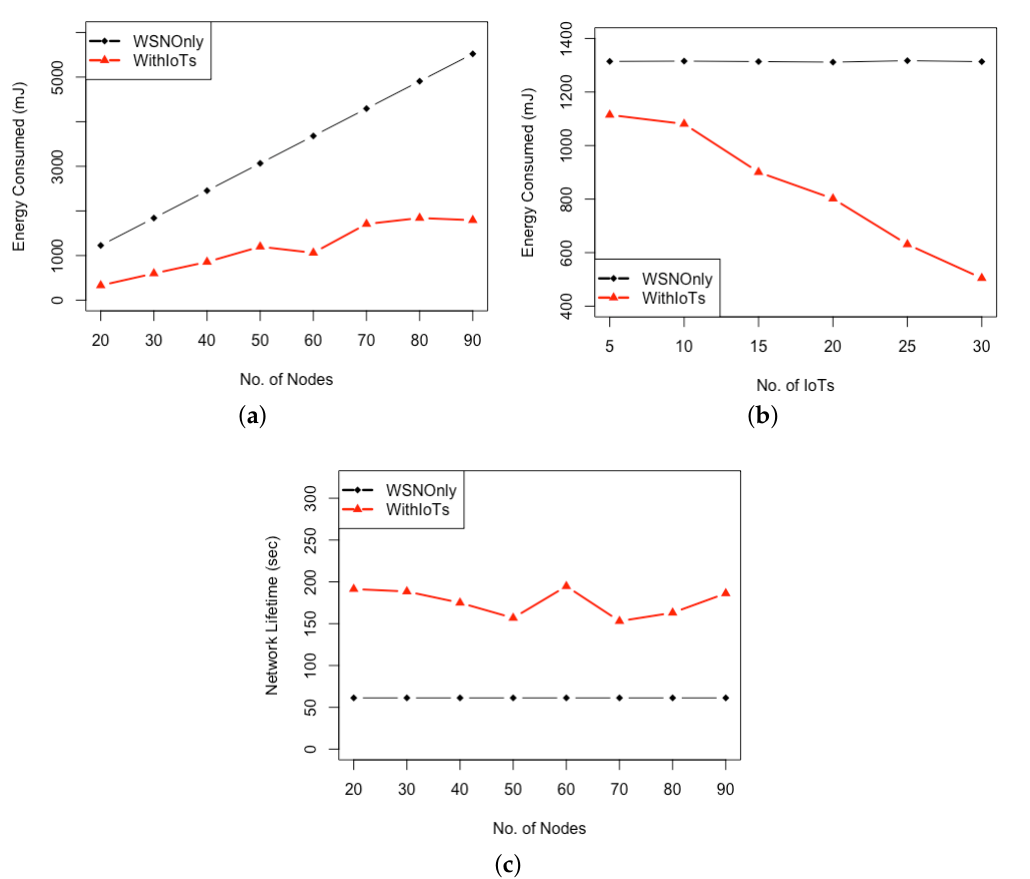
Figure 8. Energy consumption is decreased using IT Platform. ( a ) Larger the network, more energy is saved; ( b ) With increase in no. of IoTs, Sensor nodes consume less energy; ( c ) Consistent increase in Network lifetime with increase in network size.